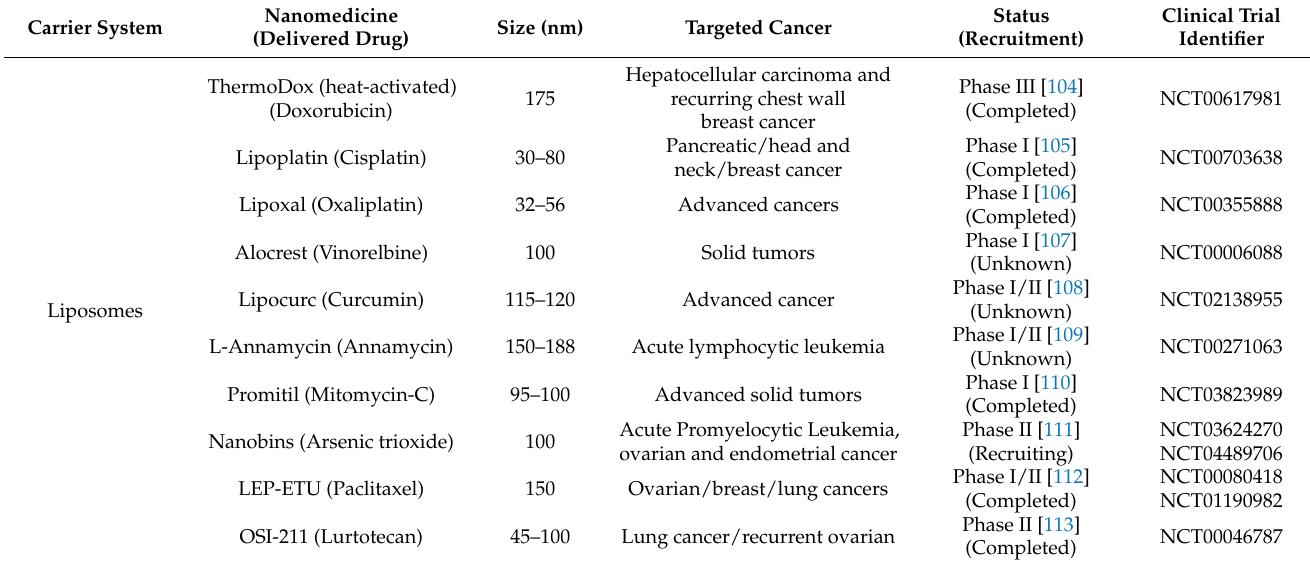
Table 2. List of nanomedicines in